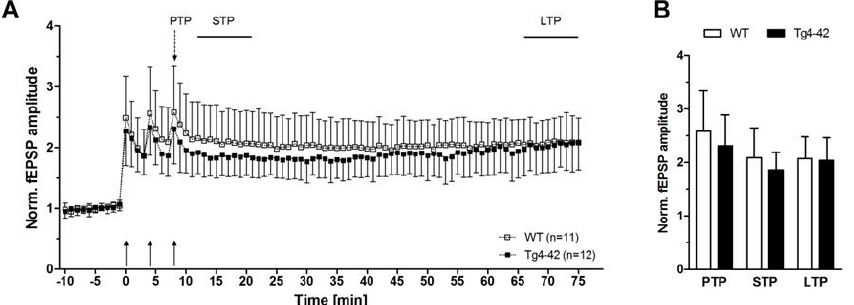
Figure 3. N-truncated Aβ 4-42 did not alter short-term and long-term plasticity in 3-month-old Tg4-42 mice (taken from [16]). Effects of Aβ 4-42 on synaptic plasticity were assessed in hippocampal slices of Tg4-42 and wildtype (WT) littermate controls. Post-tetanic potentiation (PTP = was defined as the maximal response within 1 min after the third tetanic stimulus. Short-term potentiation (STP) and long-term potentiation (LTP) were defined as the period between 12th and 21st min, and 65th and 75th min after induction, respectively. ( A + B ) Induction of potentiation by trains of high-frequency stimuli triggered PTP, STP, and LTP in both Tg4-42 and control mice. Recordings of STP and LTP revealed stable amplitudes in hippocampal slices of Tg4-42 and WT. Mean ± SD. n = number of slices per group.